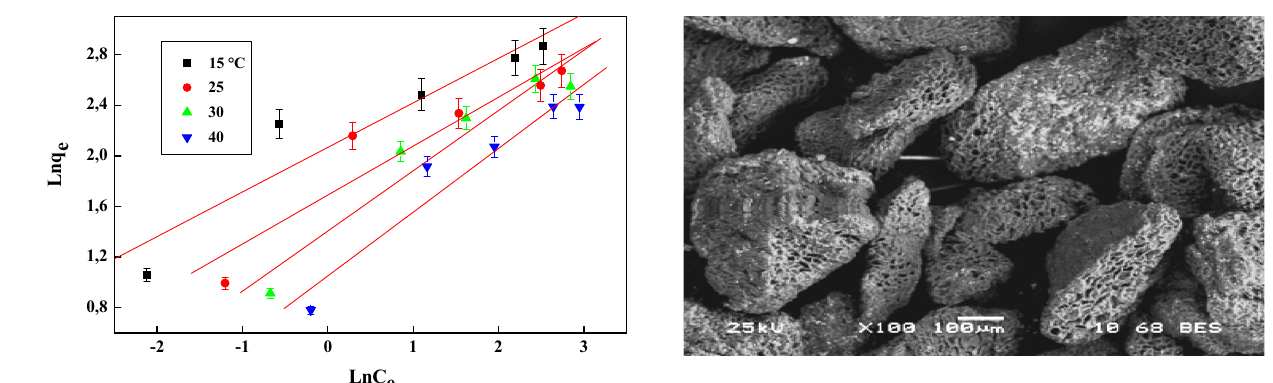
Fig. 8 SEM image of pre-treated coffee